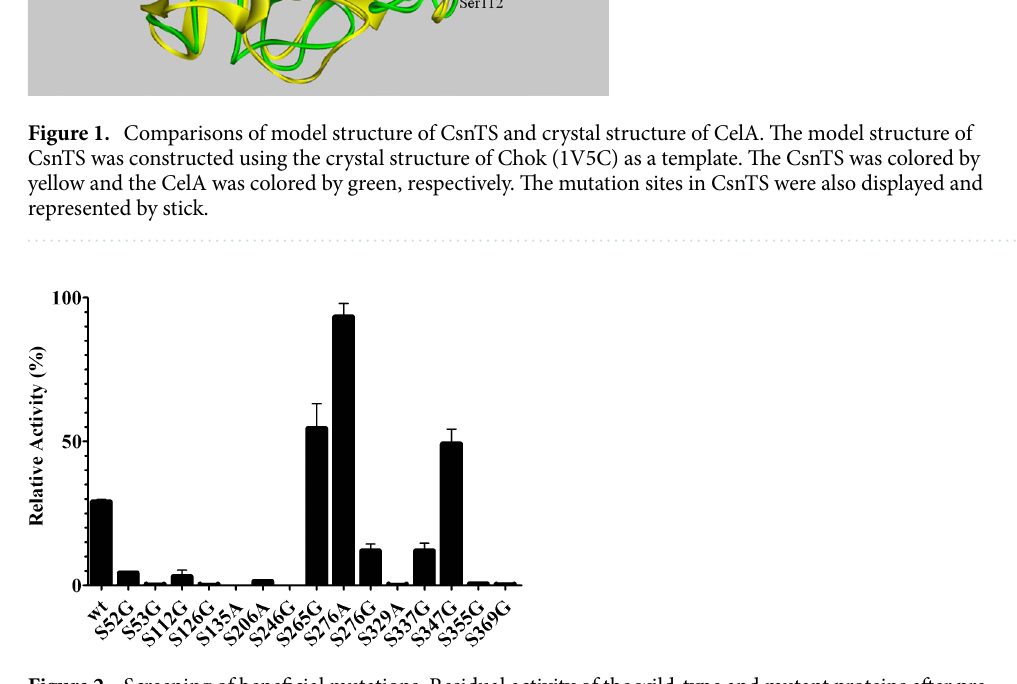
Figure 2. Screening of beneficial mutations. Residual activity of the wild-type and mutant proteins after pre- incubation at 60 °C for various